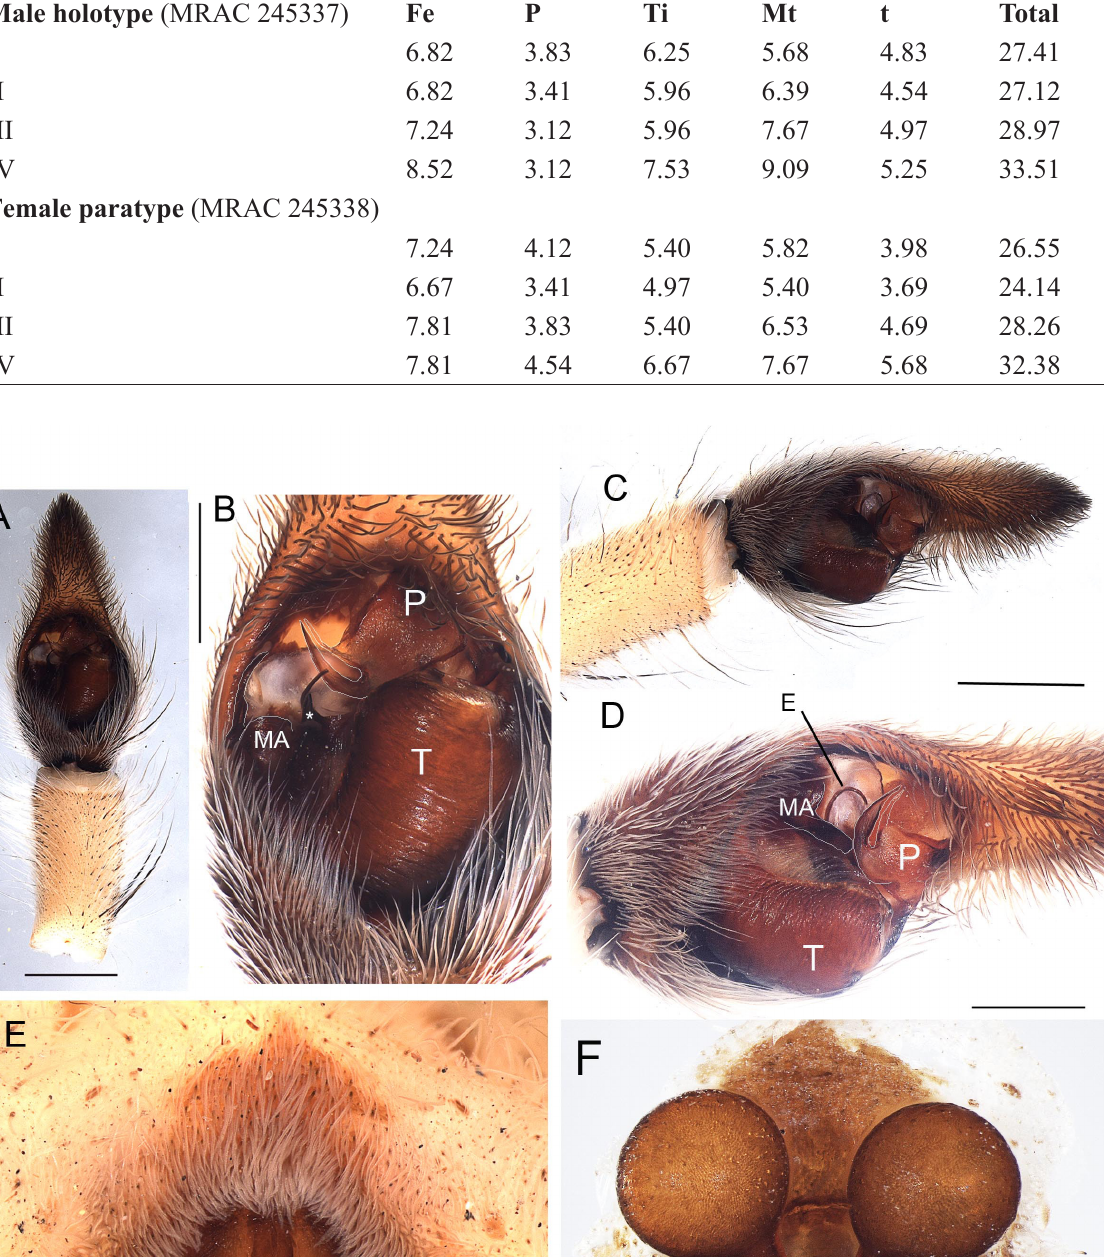
Table 1. Leg measurements of male holotype and female paratype (MRAC 245338).